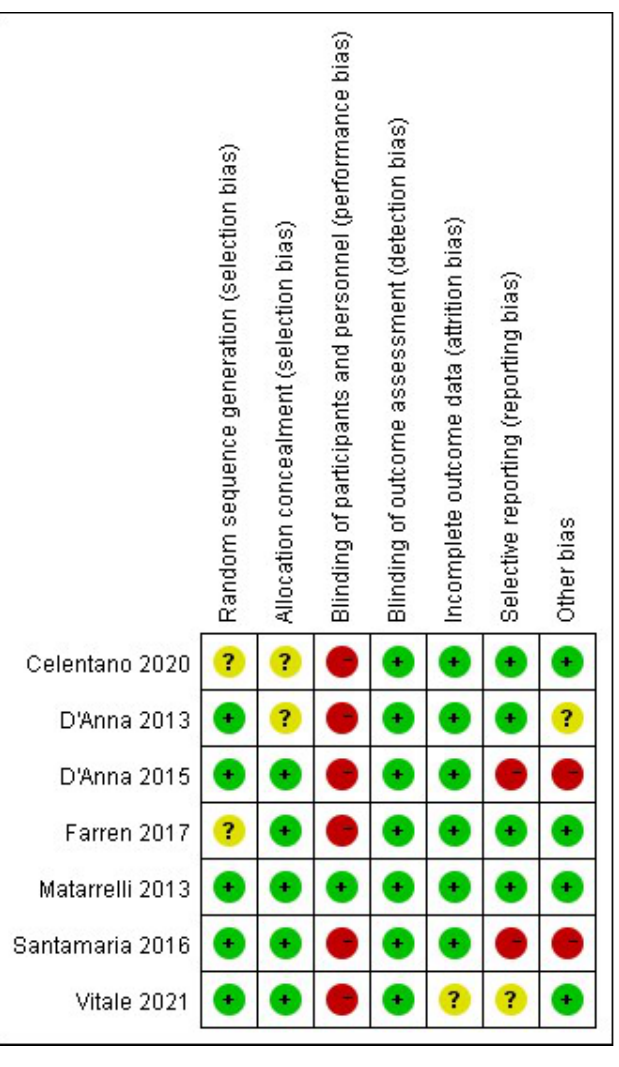
Figure 3. Review of authors’ judgement about each risk of bias item for each included study [14–